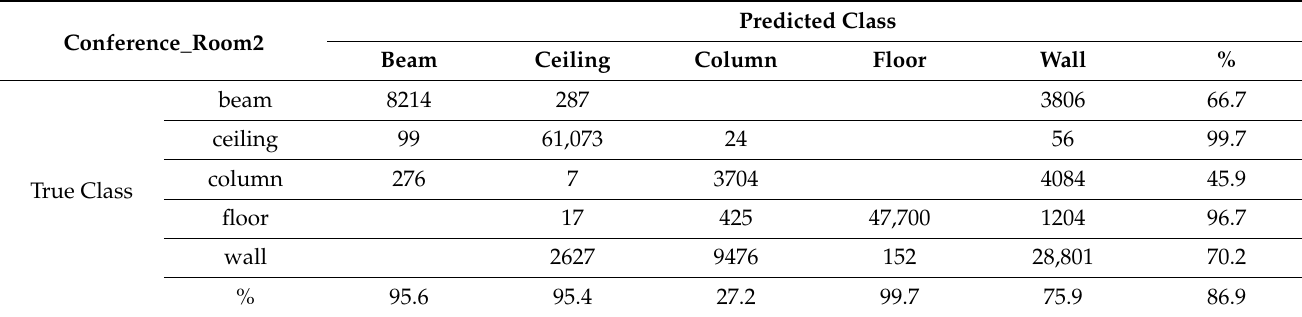
Table 1. Conference_Room2 confusion matrix. The overall accuracy is 86.9%.